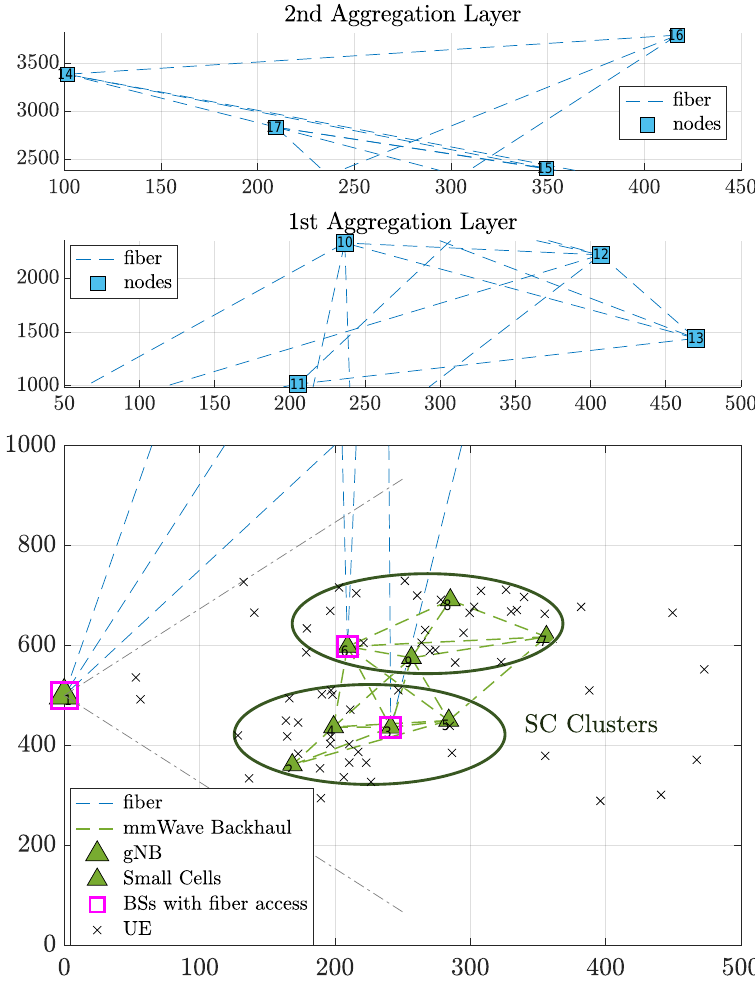
Figure 5. Simulation scenario example topology. Table 2. SFC details [15].